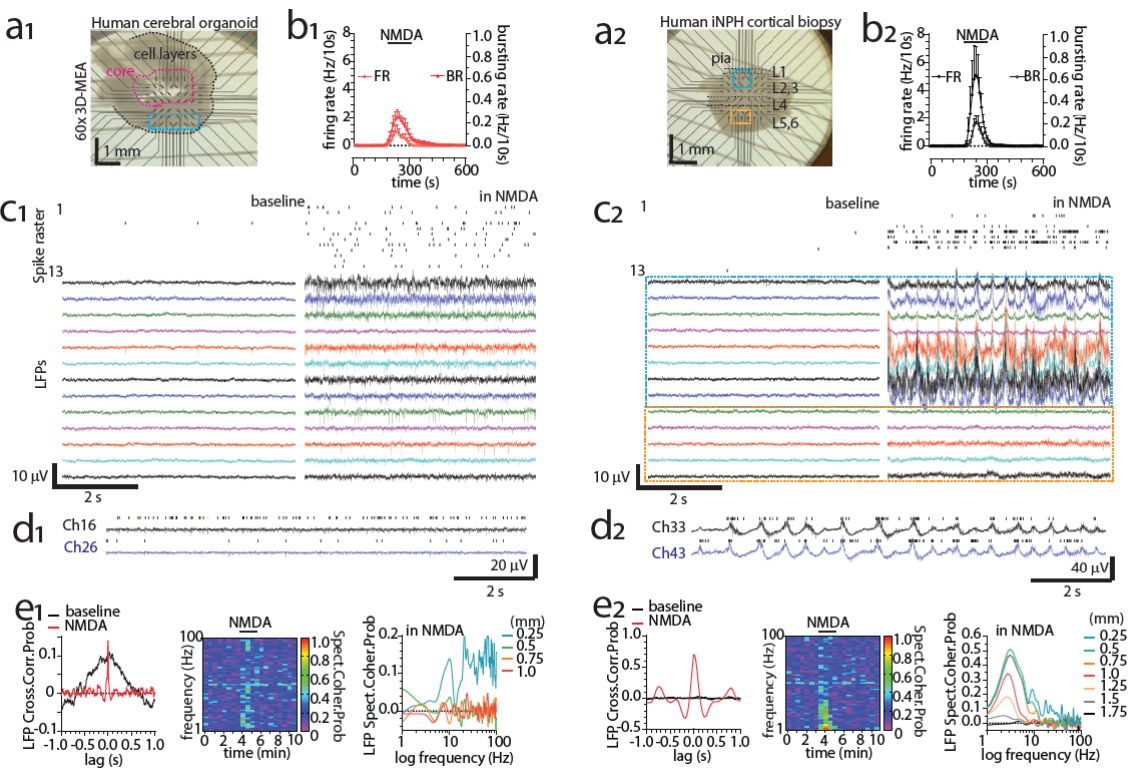
Figure 2. Functional interrogation of human cerebral organoids and acutely excised iNPH cortical slices using MEA. ( a 1, a 2 ) Image of a cerebral organoid slice ( a 1 ) and an iNPH patient cortical slice ( a 2 , frontal lobe biopsy) recorded with a 3D- MEA device hosting 60 pyramidal-tip-shaped titanium nitride (TiN) electrodes (100 µm in height), spaced at 250 µm and insulated by a thin layer of silicon nitride (Multichannel Systems). Blue/orange areas denote areas with channels of inter- est/activity, black dotted margins denote approximate cortical layers or cell layers, and magenta lines denote approximate borders of organoid core. ( b 1 , b 2 ) Spike firing and spike bursting rate timelines upon a brief exposure (2 min) to N-methyl- D-aspartate (NMDA) bath superfusion (200 µM) for a cerebral organoid slice ( b 1 ) and an iNPH patient cortical slice ( b 2 ). Bursting was defined as at least three spikes occurring above 6 standard deviations in the smoothed firing histogram (0.1 s bins, 3 widths smoothing routine). ( c 1 , c 2 ) Representative spike raster activity (top, resulting from 300 to 3000Hz band- pass filtering of the raw signal followed by a 5.5 standard deviation thresholding for spike detection) and raw local field potentials (LFP, 1 – 200 Hz band pass filtering of raw signal) recorded at baseline and in the presence of 200 µM NMDA from a cerebral organoid (13 channels, taken from the blue area shown in a 1 ) and iNPH cortical slice (13 channels, taken from blue and orange areas shown in a 2 ). ( d 1 , d 2 ) A 10s raw data detail of NMDA-induced activity (spikes and LFP) at two adjacent (250 µm) representative channels located at a vertical depth of ~400 – 500 and 600 – 700 µm from border/pial surface for a cerebral organoid and an iNPH cortical slice, respectively. Note the strong delta ( δ ) band (0.5 – 3 Hz) LFP synchroni- zation occurring in the iNPH slice and the time locked LFP-spike sequences. ( e 1 , e 2 ) Comparative, time and frequency domain analysis of markers of connectivity for NMDA-induced effects in LFPs for the pairs of channels presented in d 1 ,d 2 . Cross-correlation probability analysis of time series (left), cross-spectral coherence probability timeline (mid) and baseline- subtracted spectral coherence probability against channel vertical distance, collectively demonstrating the relatively weak, spatially and spectrally restricted, NMDA-induced synchronicity for the organoid circuit against the robust behavior of the human cortical slice.